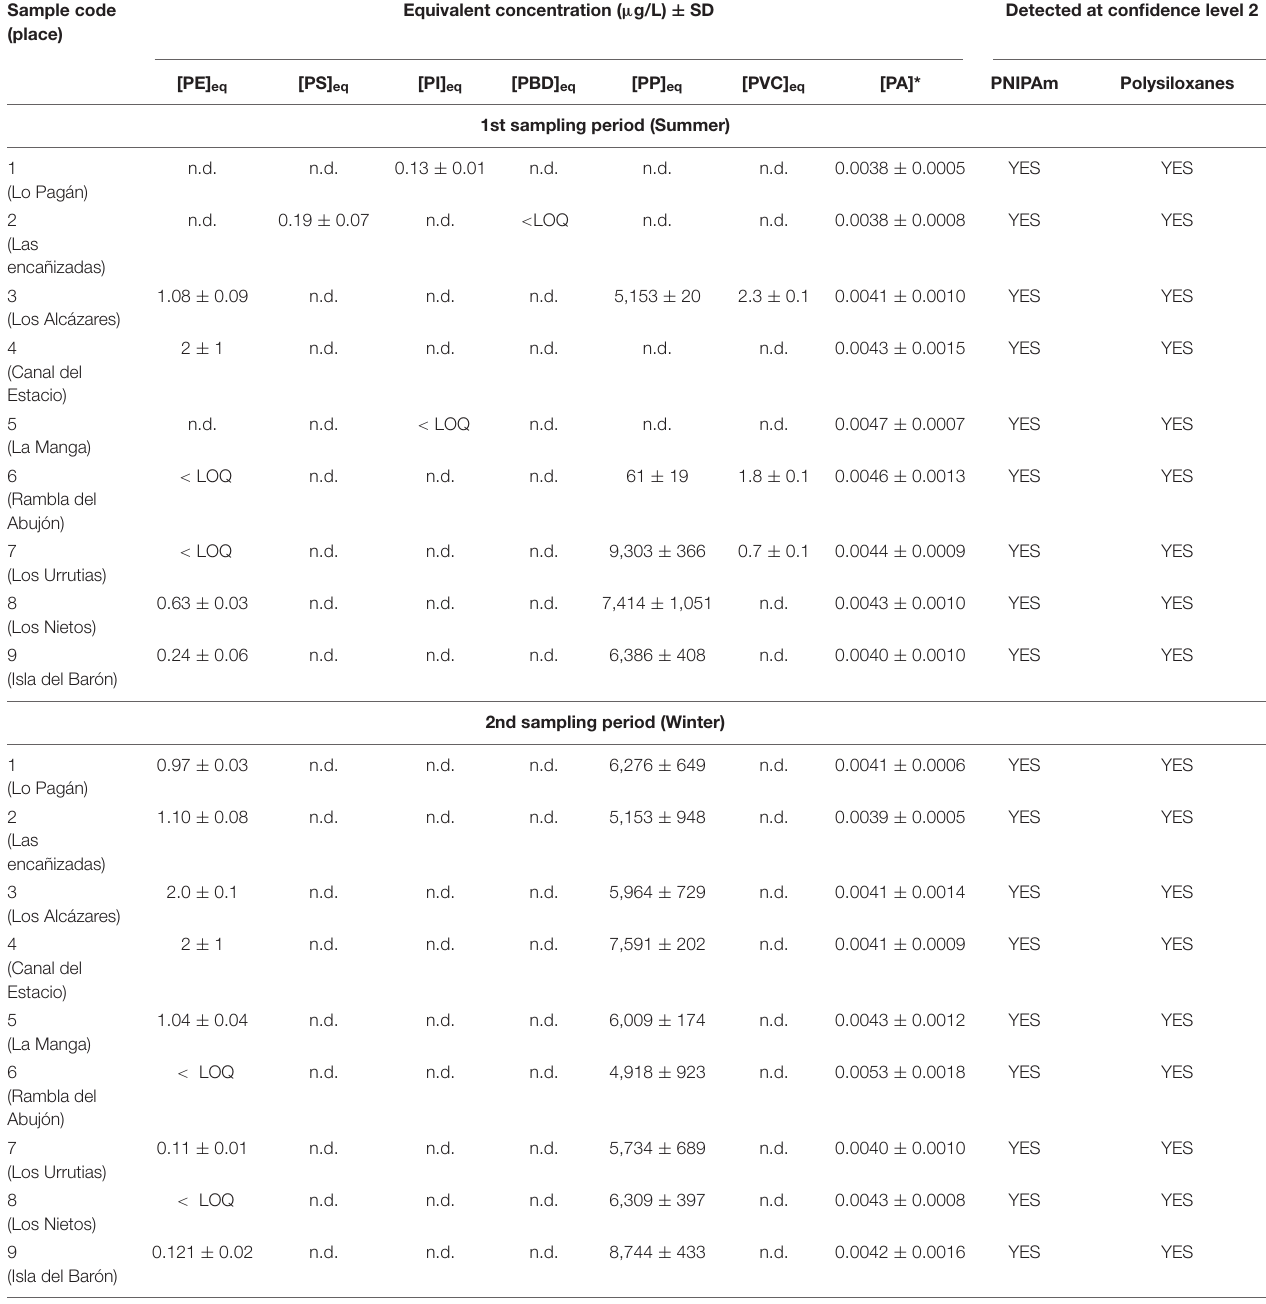
TABLE 2 | Concentration of MPLs/NPLs polymers from suspended material samples expressed in equivalent concentration in µ g/L ( ± SD). Sample code